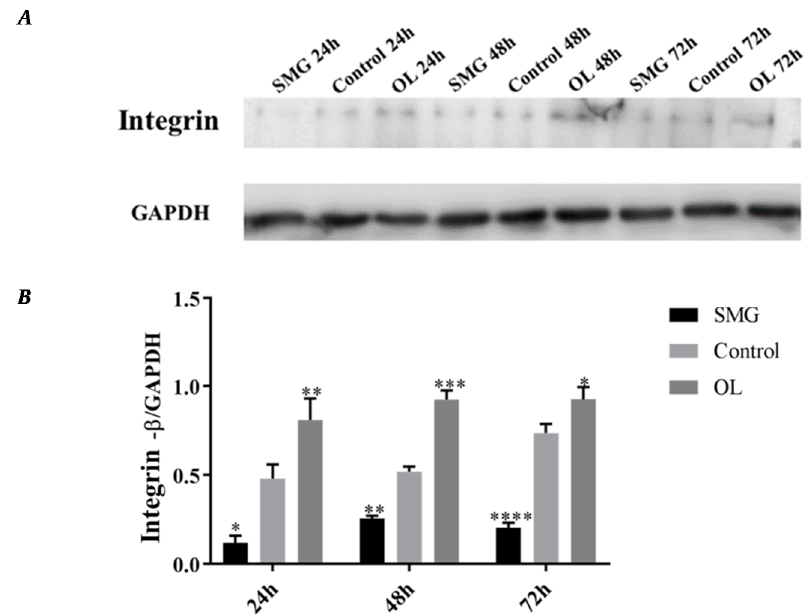
Figure 9. Western blot analysis of integrin β 1 in MCF-7 cells after mechanical changes. ( A ) Results for Western blots. ( B ) Reflective densitometry of Western blots. * p < 0.05, Significant di ff erence; ** p < 0.01, *** p < 0.001 and **** p < 0.0001, extremely significant di ff erence.